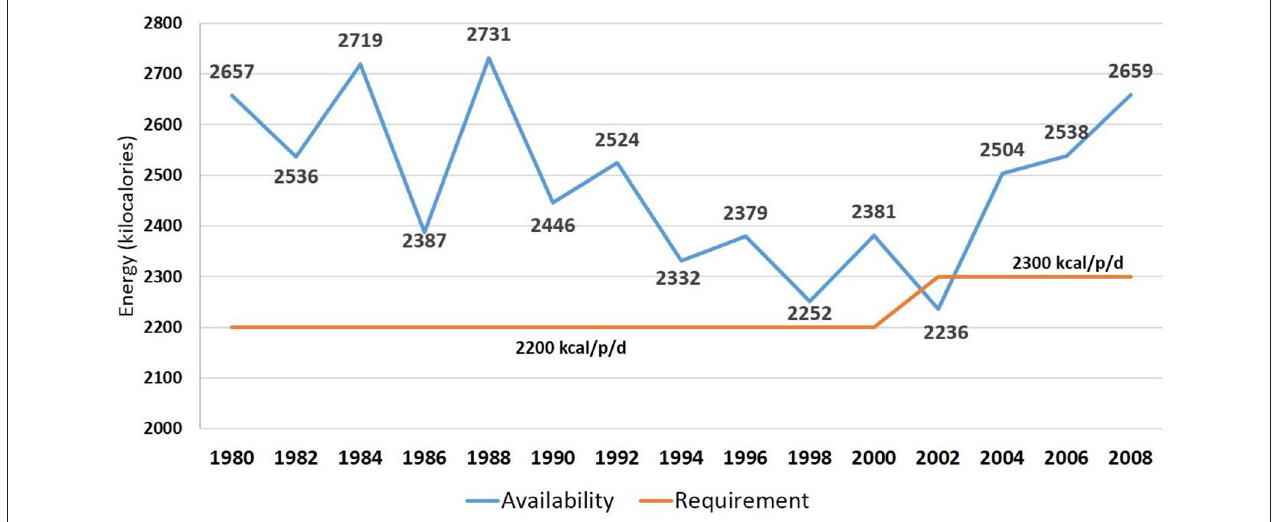
FIGURE 2 | National energy availability. Venezuela 1980–2008 (includes alcoholic beverages). Source: Food Balance Sheet. Instituto Nacional de Nutrición